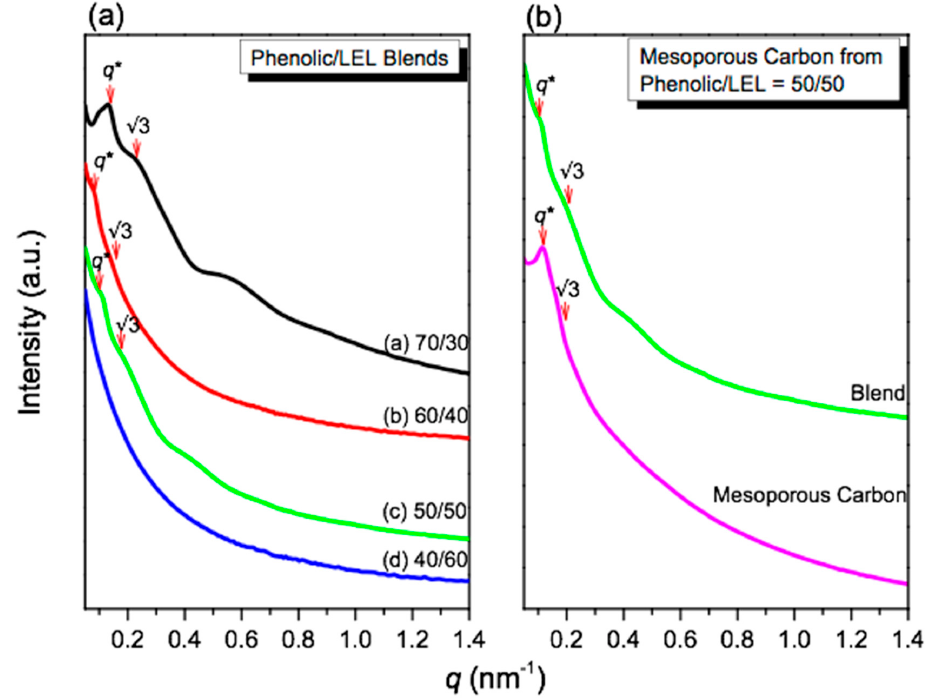
Figure 3. ( a ) SAXS patterns of various phenolic/LEL blends and ( b ) SAXS patterns of mesoporous carbon from phenolic/LEL = 50/50 blend. carbon from phenolic / LEL = 50 / 50